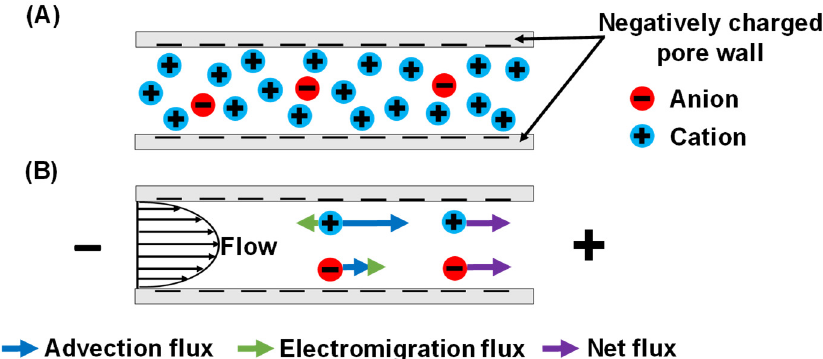
Figure 1. ( A ) Qualitative ion distribution in a negatively charged nanopore and ( B ) scheme of streaming potential and ion flux components during flow through the pore. Due to anion exclusion, the cation advection flux is much larger than the anion advection flux. The spontaneously